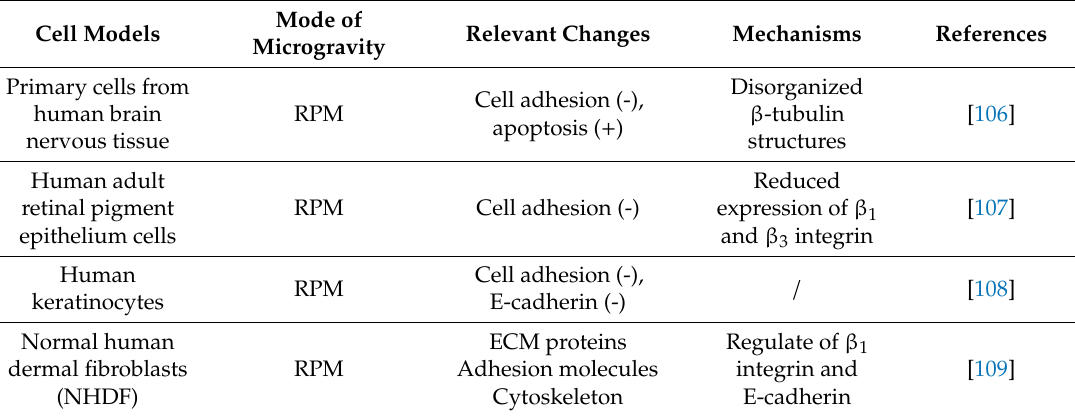
Table 8. E ff ects of microgravity on adhesion of other